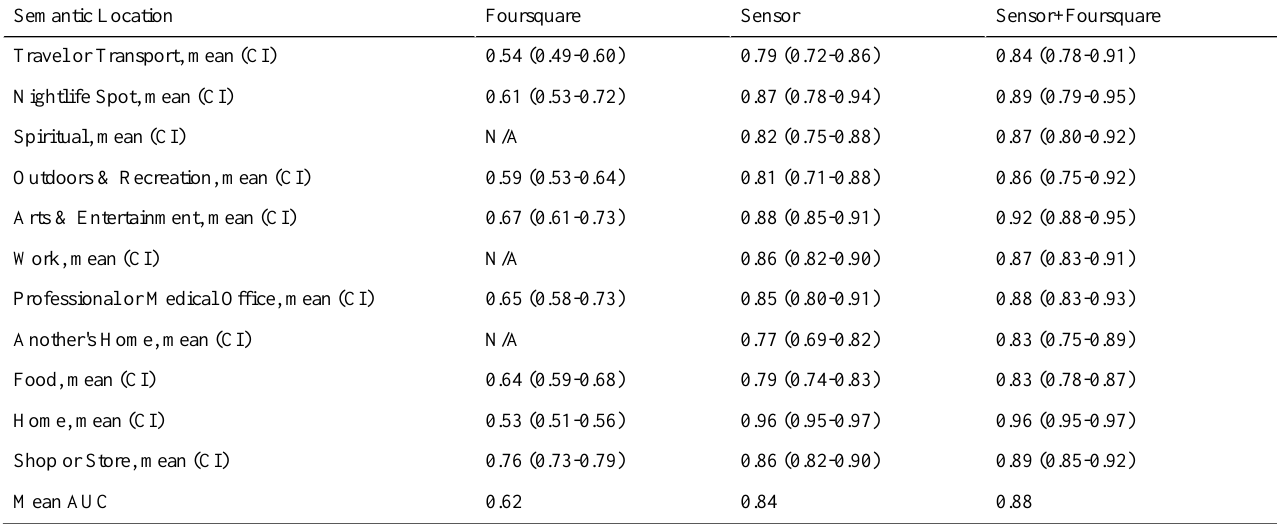
Table 2. Mean area under the curve (AUC) in detecting each location category, using Foursquare only, mobile phone sensor features only, and both. Note that we could not use Foursquare to detect Work, Another’s Home, or Spiritual locations; hence there are no results. Sensor+FoursquareSensorFoursquareSemantic